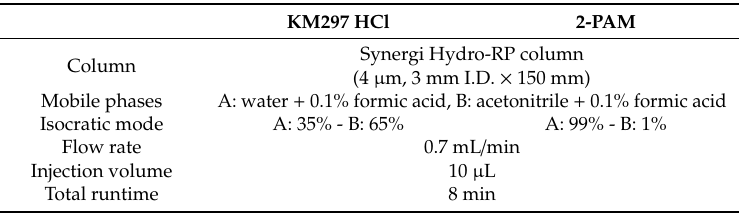
Table 1. Chromatographic conditions for LC-MS / MS analysis.